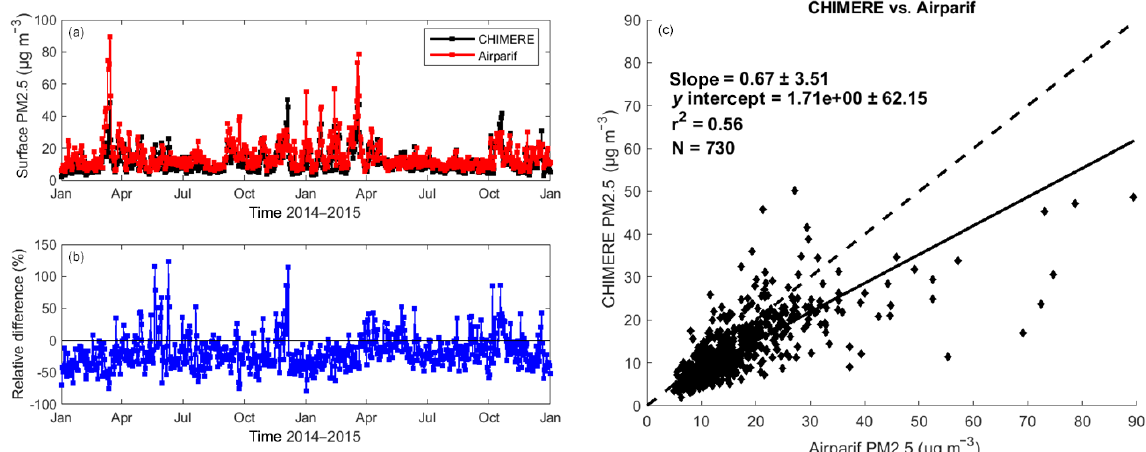
Figure 11. Comparison between PM 2 . 5 concentrations derived from the Airparif network and the CHIMERE model outputs. (a, b) Time series of the daily mean PM 2 . 5 concentrations (in µgm − 3 ) observed at the surface with the Airparif network (red) and calculated with the CHIMERE model (black), associated with relative differences (in %) calculated as model observations for 2014 and 2015. (c) Correlation plots between daily mean PM 2 . 5 concentrations derived from the CHIMERE model versus the Airparif